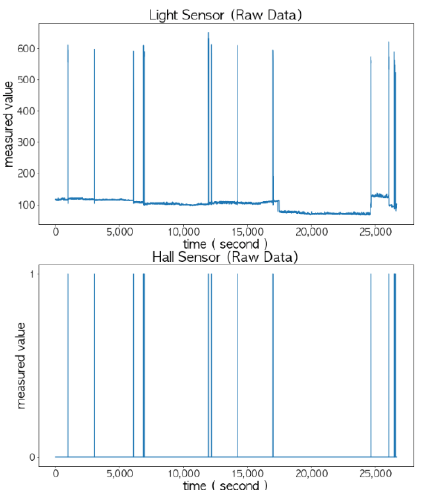
Figure 11. Changes in the measured values of the light sensor and the Hall sensor with respect to the opening and closing status of the door (the unit of the x-axis is in seconds).